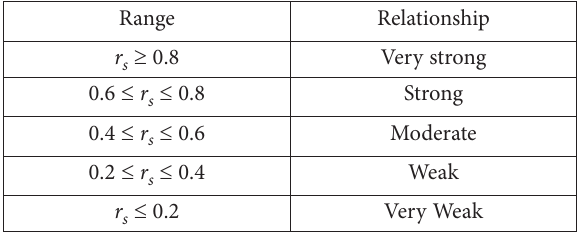
Table 16. Correlation coefficients between the ranking results of COPRAS-G and the other methods Method